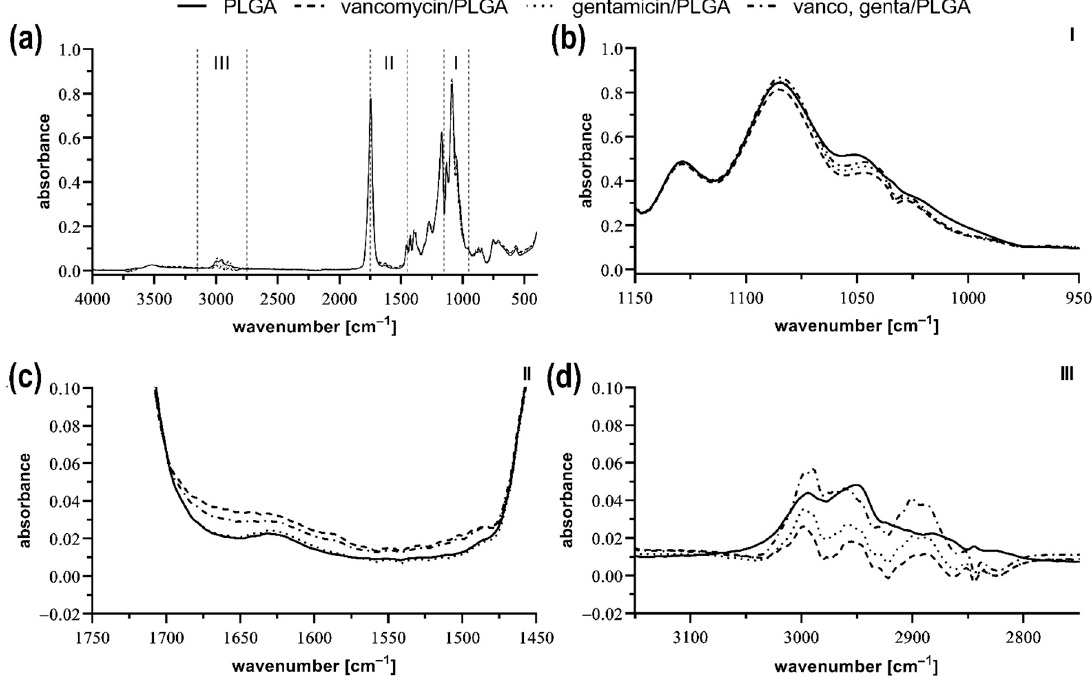
Figure 5. FT-IR spectra of the pure PLGA ( a ), the vancomycin-loaded PLGA, the gentamicin-loaded PLGA, and the both vancomycin and gentamicin-loaded PLGA. FT-IR spectra of region I (950 − 1150 cm − 1 ) ( b ), region II (1450 − 1750 cm − 1 ) ( c ), and region III (2750 − 3150 cm − 1 ) ( d ).